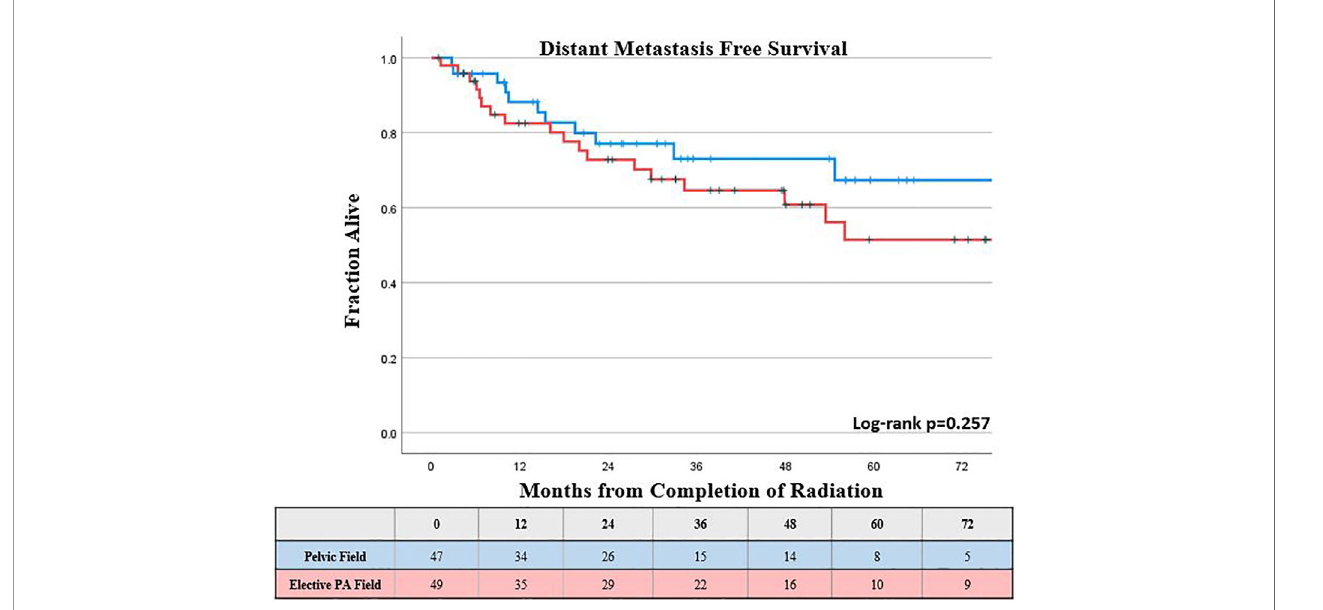
FIGURE 2 | Kaplan-Meier estimated distant metastasis free survival by type of treatment fi eld.